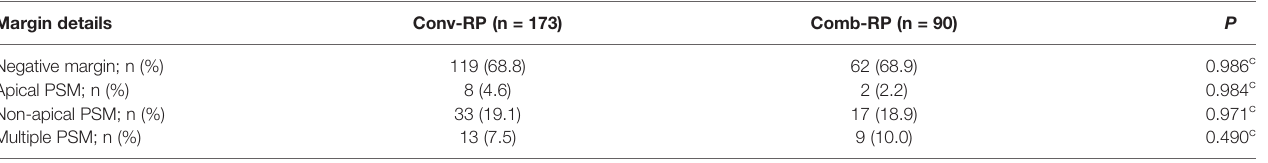
TABLE 3 | Margin details of patients undergoing Conv-RP or Comb-RP. Margin details